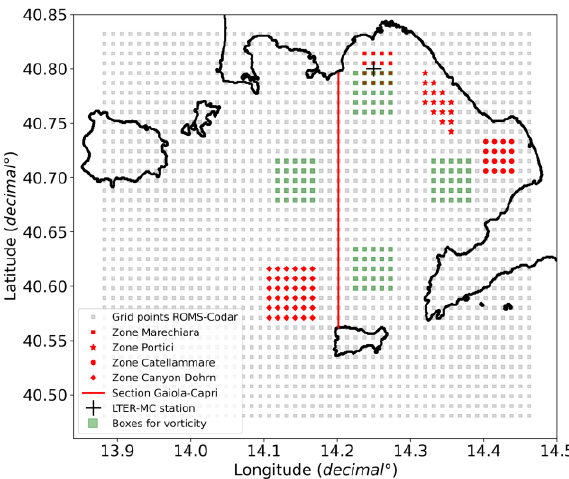
Figure 4. Common grid points between HFR observations and GNAM model in the Gulf of Naples (coastline in black). Benchmark’s areas are indicated in red (zones of interest and latitudinal section) and green (boxes to infer the vorticity index). The LTER-MC coastal station is located with the cross.